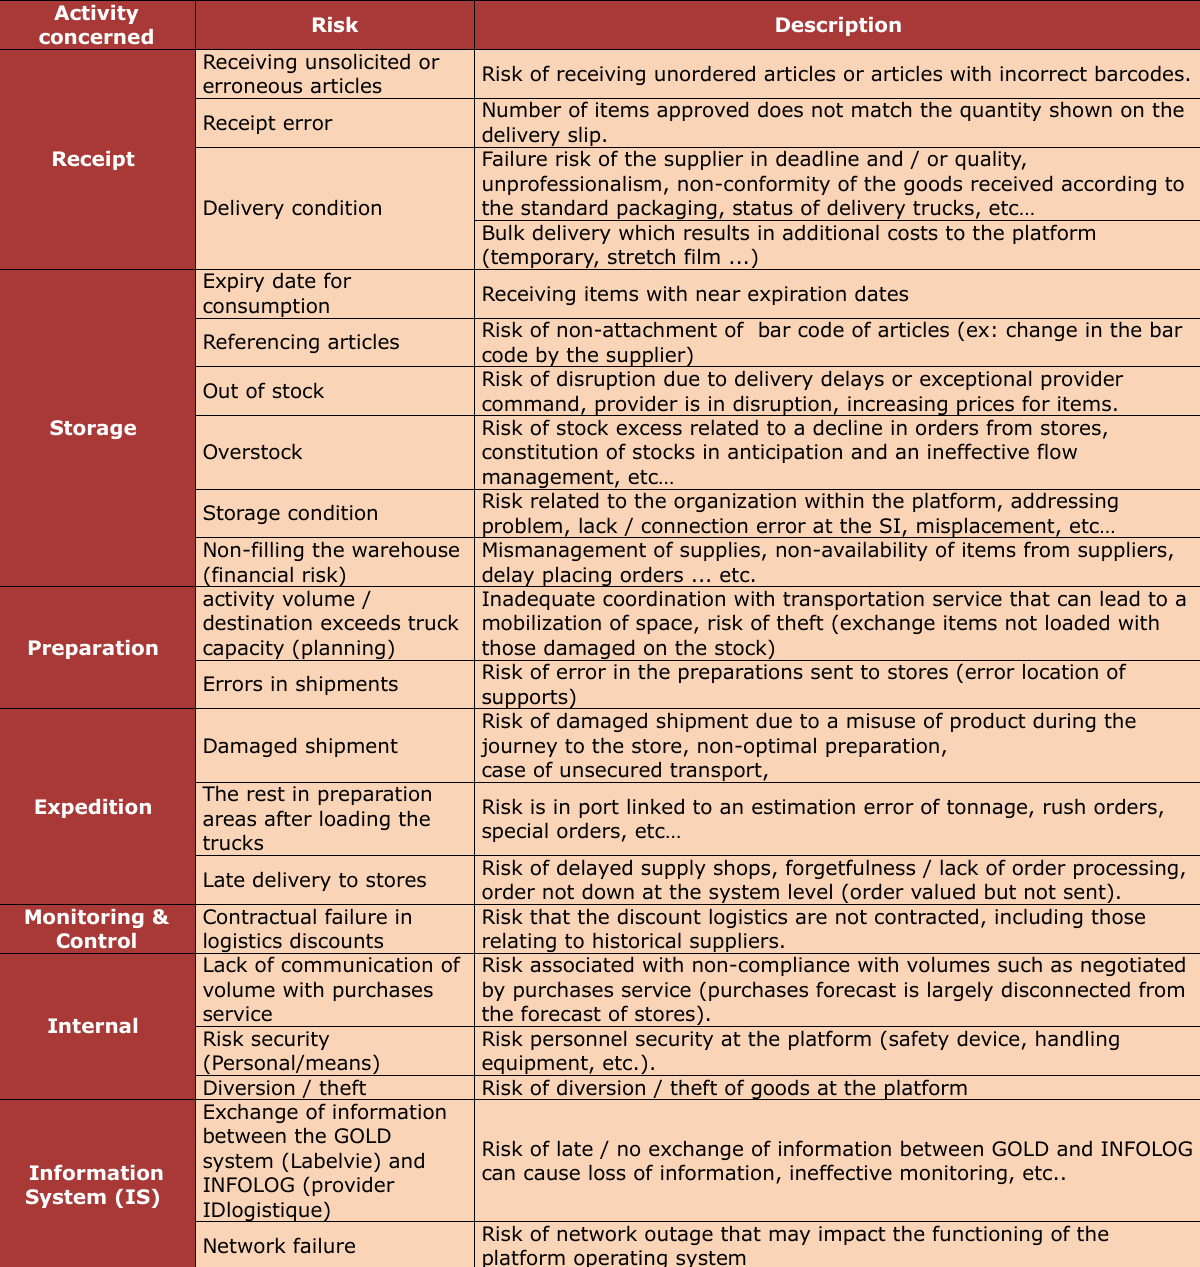
Table 1. Risk of outsourcing logistics (Label'Vie